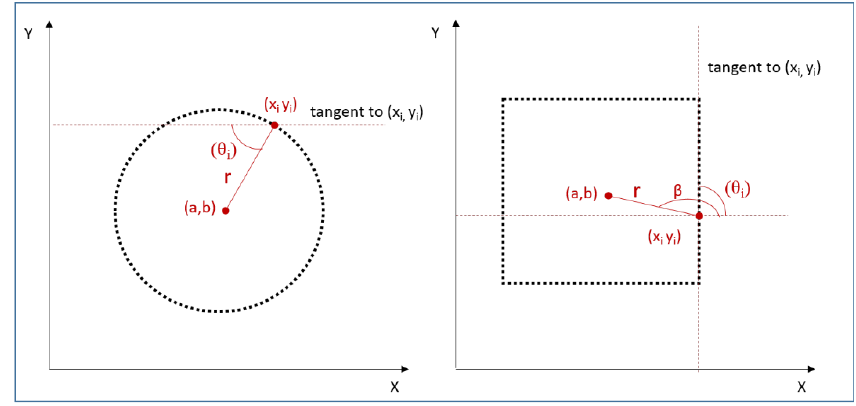
Figure 3. Parameters involved in the CHT ( left ) and GHT ( right ) [9] for column